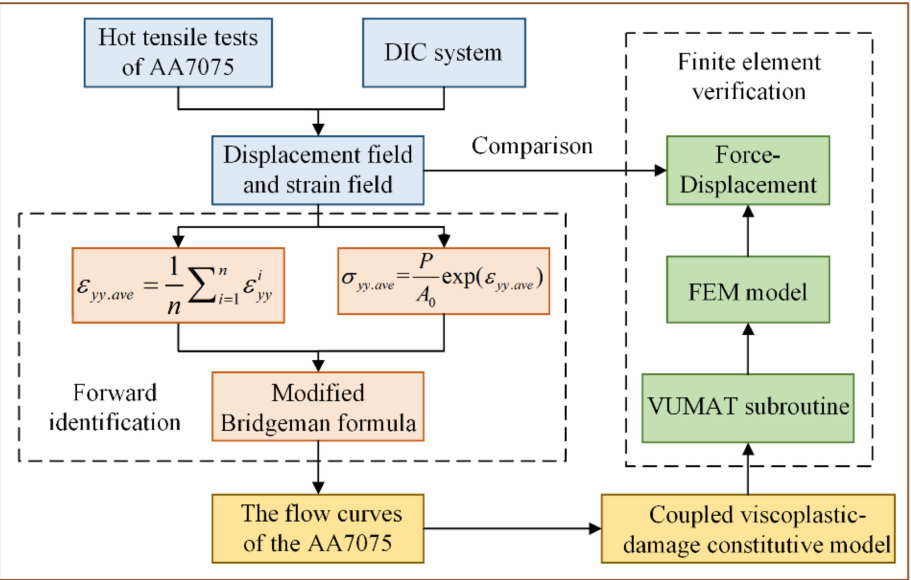
Figure 7. Flow chart of the forward identification method. 3.1. Calculation Method of Average True Stress–Strain Curve Based on Strain Measurement Technology